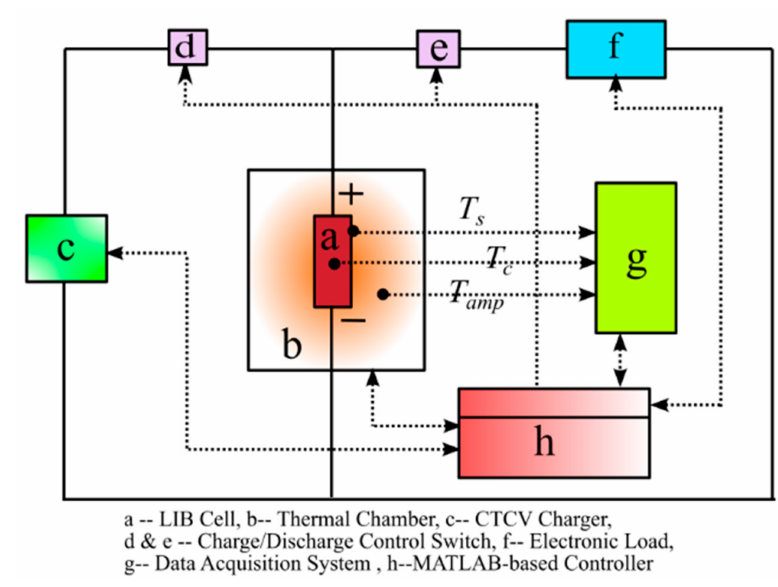
Figure 5. Schematic layout of the Battery Automated System